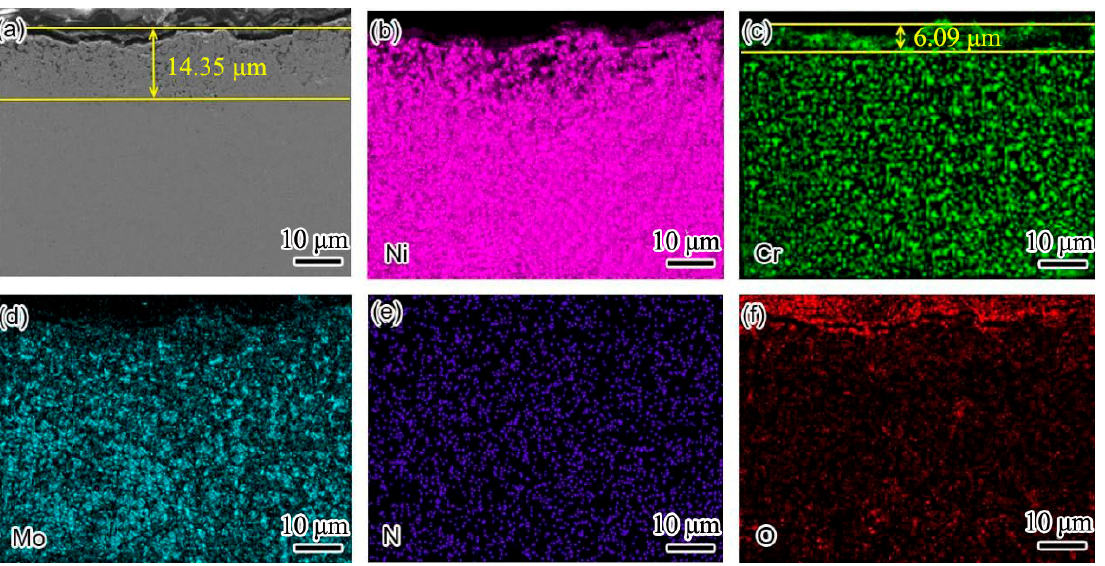
Figure 6. The cross-sectional element distribution of 3 nitrogen-containing low-nickel weld claddings after corrosion for 10 h. ( a ) Cross section morphology of 3 nitrogen-containing low-nickel weld claddings; ( b ) Ni element distribution; ( c ) Cr element distribution; ( d ) Mo element distribution; ( e ) N element distribution; ( f ) O element distribution.